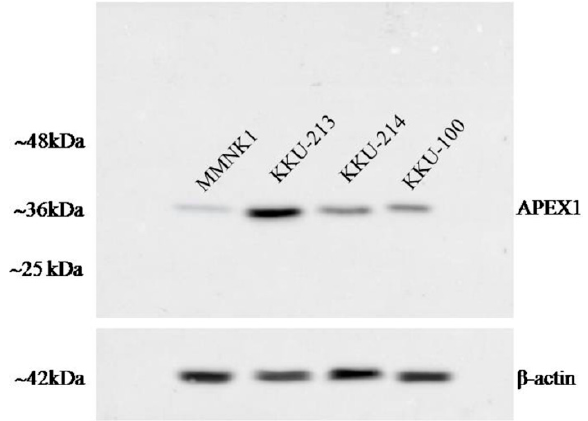
Figure 6. The image of western blot. The expression of APEX1 in three CCA cell lines and control immortalized cholangiocyte MMNK1 cell line.